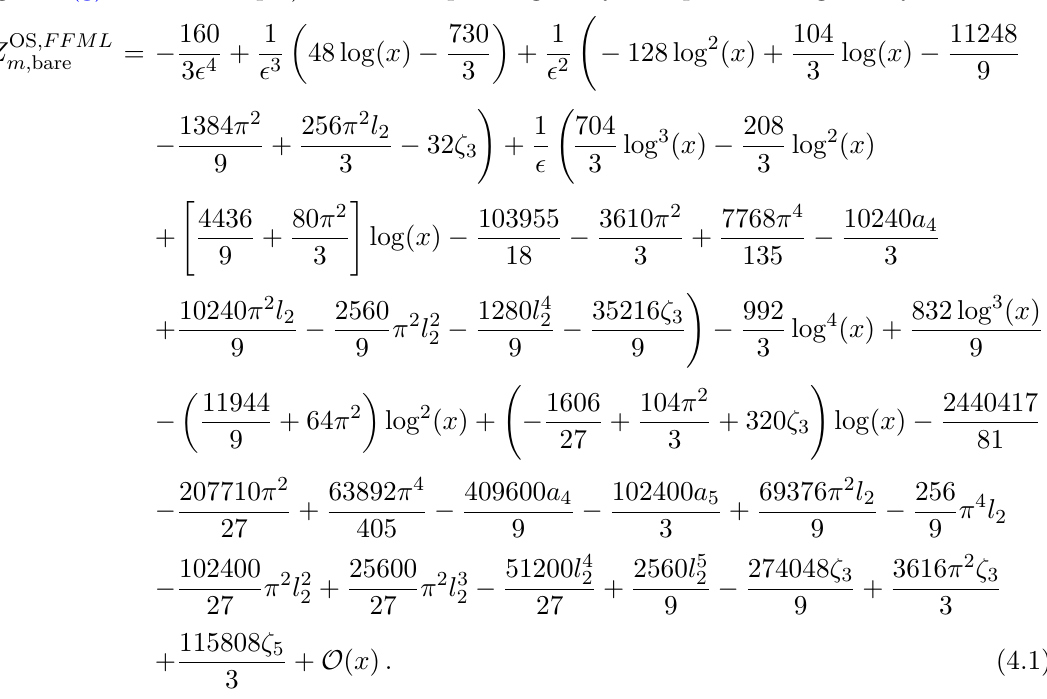
n m n l (a) and C F C A n m n l (b). F